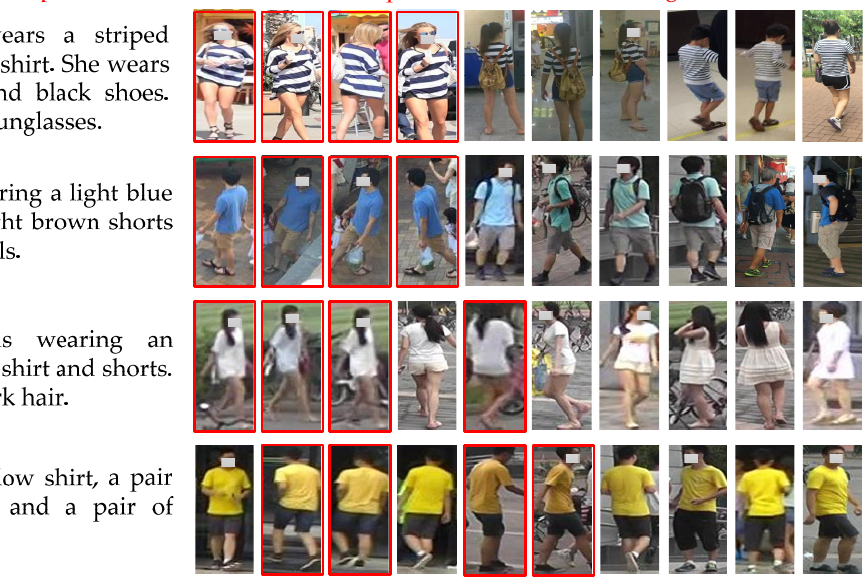
Figure 9. Examples of top-10 person search results by our method. The true matches are marked by